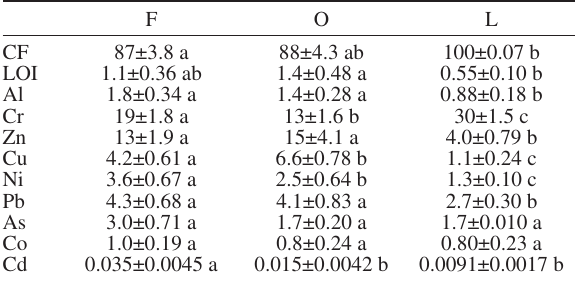
Table 2. – Coarse fraction (>63 μm, CF), loss on ignition (LOI, %) Al content (%), and concentrations (μg g –1 dw) of Cr, Zn, Cu, Ni, Pb, As, Co and Cd in sediments collected at sites F, O and L in November 2010, March, August and October 2011; mean values (±SD; n=3); different letters (a, b, c) correspond to values signifi- cantly (p<0.05) different among sites. F